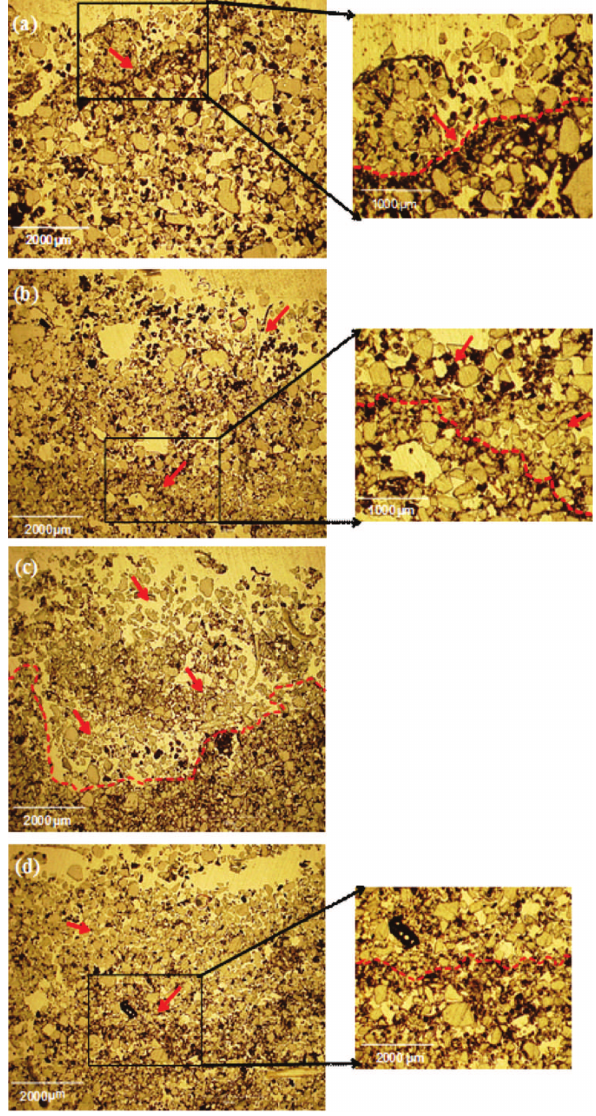
Figura 2. Detalhes da crosta formada no PR em função das lâminas de chuva aplicada, sobre um Argissolo Vermelho-Amarelo. (a), (b), (c), (d) correspondem a 0, 27, 54 e 80 mm, respectivamente. Setas nas figuras indicam material disperso acumulado, podendo ser zonas de material grosso ou